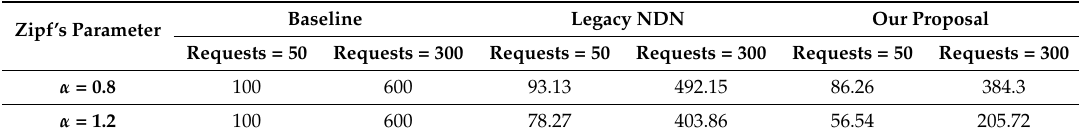
Table 3. Total number of transmitted Interests in the